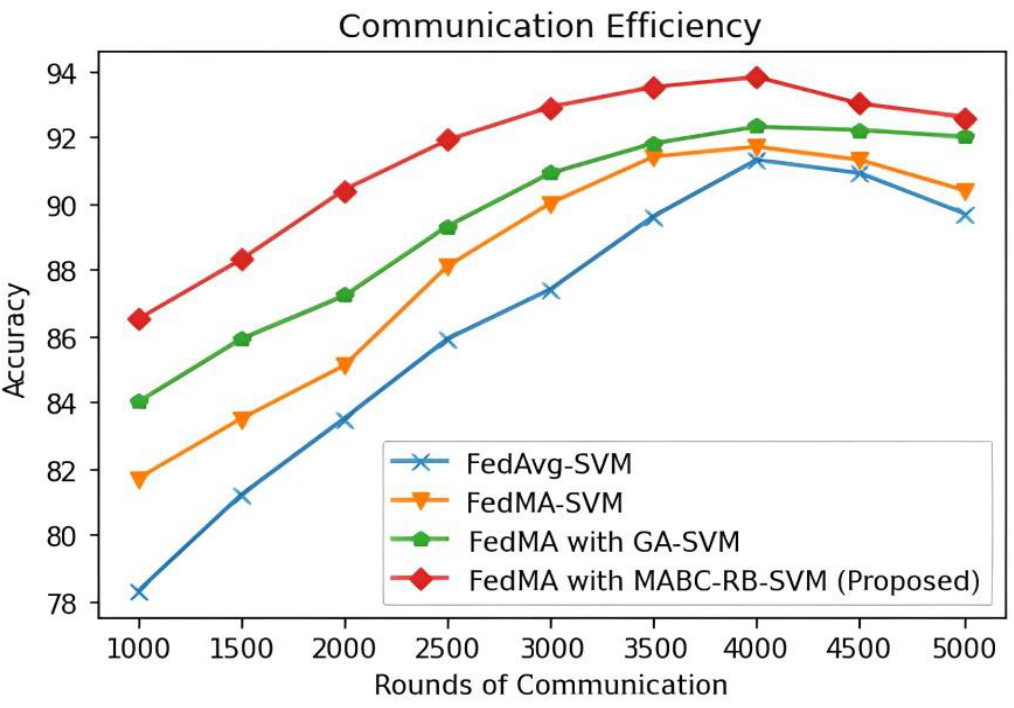
Figure 3. Comparison of convergence rate with prediction accuracy.